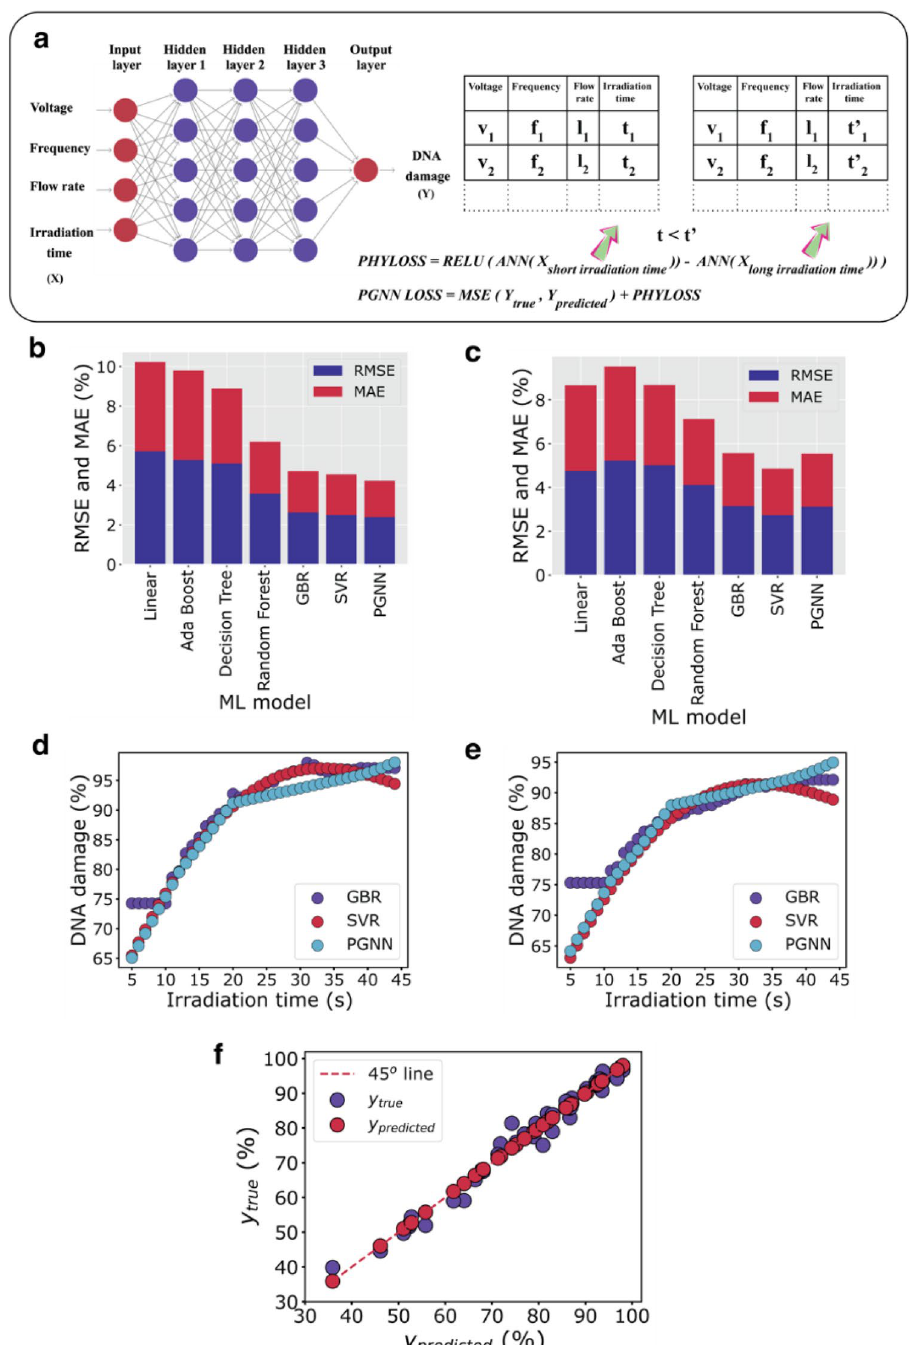
Figure 1. Overview of the predictive modeling. ( a ) Schematic diagram of the implementation of PGNN. Summary of evaluation scores on the test data ( b ) and cross-validation scores ( c ) for the different ML models. The metrics include root-mean-squared error (RMSE) and mean absolute error (MAE). Time dependence for DNA damage was modeled for two sets of process parameters: 10 kV, 4 kHz, and 2 standard liters per minute (slm) ( d ), and 11 kV, 3 kHz, and 2 slm ( e ), indicating physical violation for GBR and SVR. ( f ) Evaluation plot of the un-augmented test data for PGNN. Evaluation scores are R 2 = 0.976, RMSE = 2.45, and MAE =